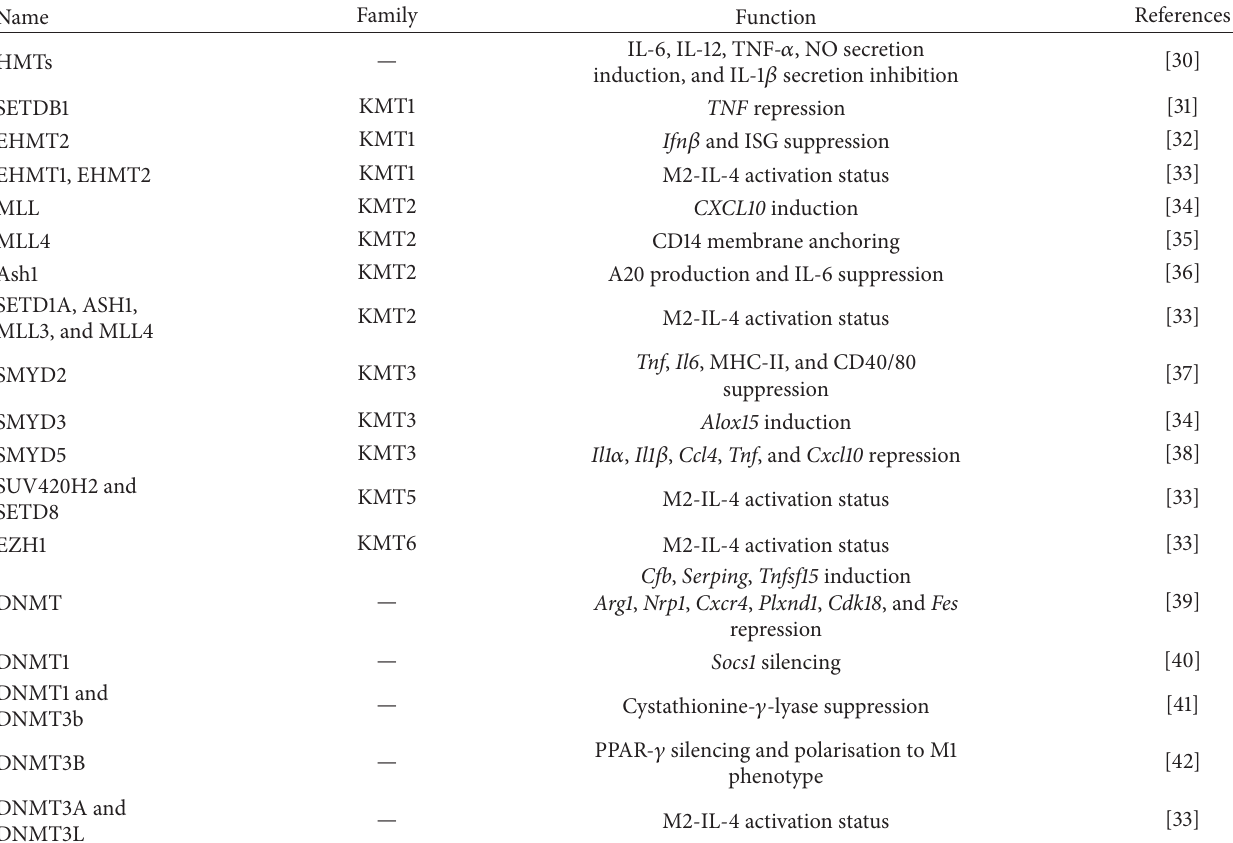
Table 1: HMTs and DNMT involved in macrophage